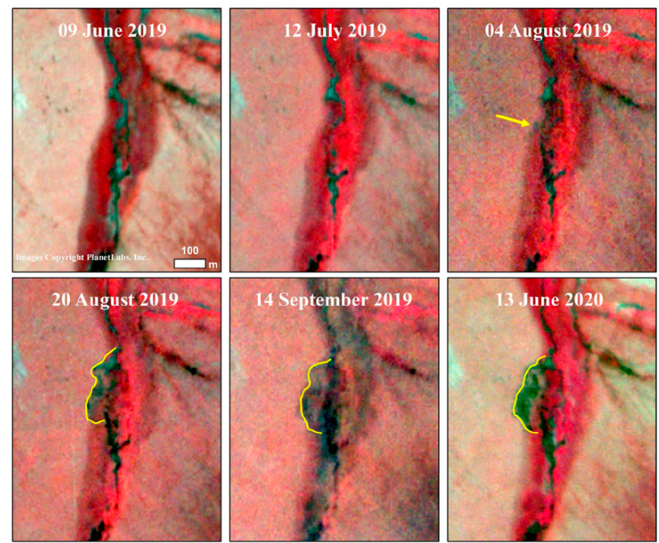
Figure 4. PlanetLabs, Inc. CubeSat false-color infrared image time series of the beaver-induced permafrost degradation feature at the Swan Lake Creek study site. The high temporal resolution offered by the PlanetLabs, Inc. constellation of CubeSats provides critical information on the timing of events associated with the beaver-induced permafrost degradation feature. An initial disturbance to the near-surface permafrost terrain is evident in the image from 4 August 2019 (yellow arrow). The image from 20 August 2019 shows that the majority of the disturbance occurred between 4 August and 20 August 2019. Images acquired later in 2019 and in early 2020 indicate that thermokarst processes are likely increasing the area of the permafrost degradation feature at a slower rate since its rapid development.